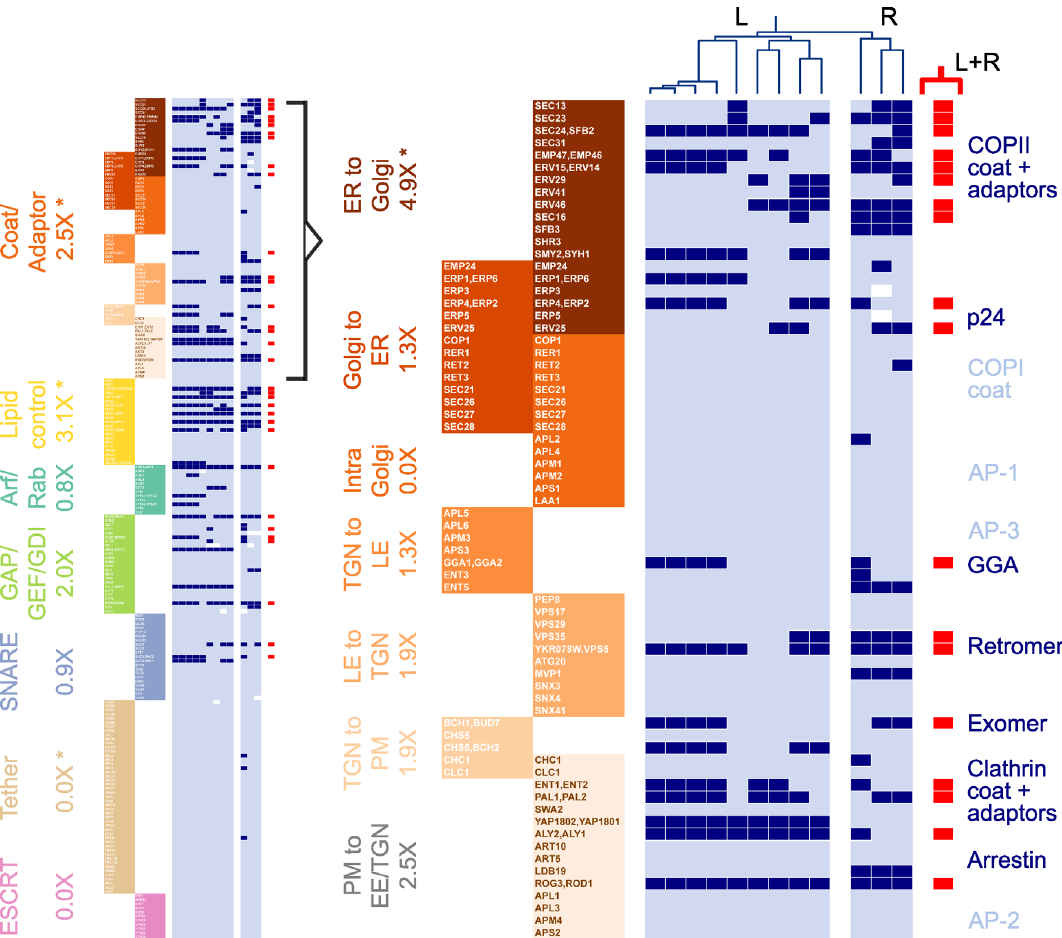
Figure 2. Function-specific and pathway-specific modules. We group 204 ancestral vesicle traffic genes into seven functional classes. We further sub-divide the Coat/Adaptor class into seven pathway-specific modules. ER endoplasmic reticulum, PM plasma membrane, EE/TGN early endosome/trans-Golgi network, LE/PVE late endosome/pre-vacuolar endosome. Note that some gene products can act at multiple locations. Genes are labeled by the names of the corresponding S. cerevisiae homologs. We track whether each gene is present as a doublet (dark blue), a singleton (light blue), or has been completely lost (white) in each of the 12 species of the WGD clade. This information is represented as a matrix: rows correspond to genes, columns correspond to species. The L and R sub-clades are separated for visual clarity. The Coat/Adaptor portion of the matrix is shown expanded on the right. Paralogs present as doublets in both the L and R sub-clades are highlighted in red. Under each class or module description, we show the enrichment of L+R doublets compared to the background expectation. P-value calculations are described in the main text and “Methods”; * represents statistically significant enrichment or